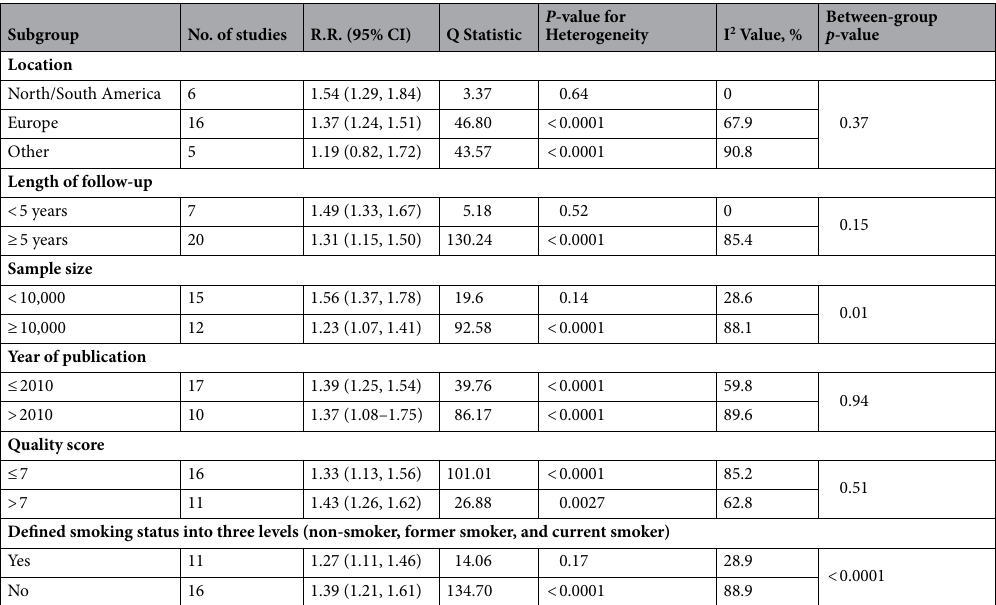
P -value for Heterogeneity I 2 Value, %